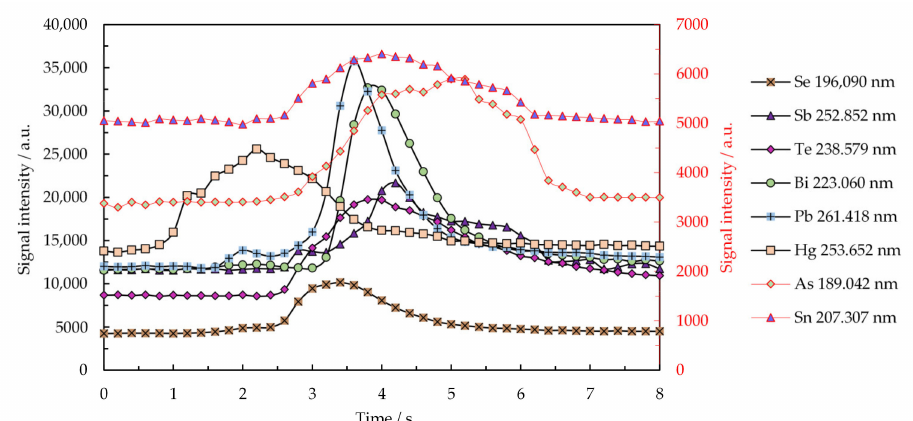
Figure 3. Transient emission signals for the most sensitive lines of As, Bi, Sb, Se, Te, Hg, Pb, and Sn recorded with the Maya2000 Pro microspectrometer. Conditions: 10 µ L sample volume containing 3 µ g mL − 1 As, Bi, Se, Te, and Sn; 1 µ g mL − 1 Pb and Sb; and 0.2 µ g mL − 1 Hg; drying temperature: 80 ◦ C for 180 s; electrothermal vaporization temperature: 1300 ◦ C for 10 s; integration time per episode: 200 ms; plasma power: 15 W; Ar flow rate: 150 mL min − 1 ; observation height: 0.8 mm above the electrode tip.